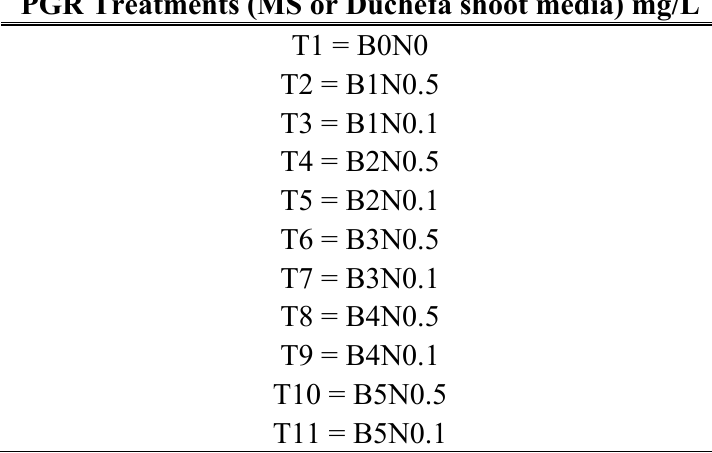
Table 2. Different PGR combinations (BAP and NAA) in semi-solid MS or Duchefa shoot